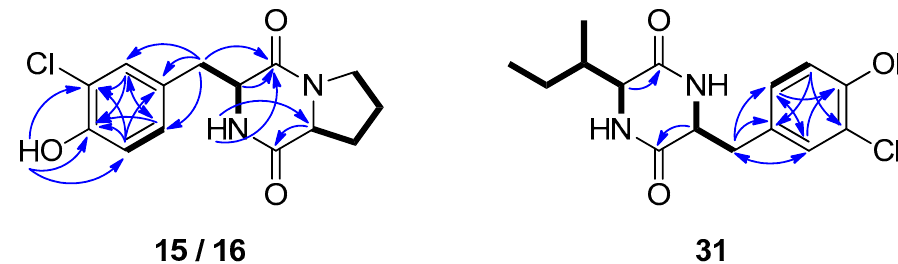
Figure 3. COSY (bold bonds) and important HMBC (arrows) correlations observed for compounds 15 / 16 and 31 .